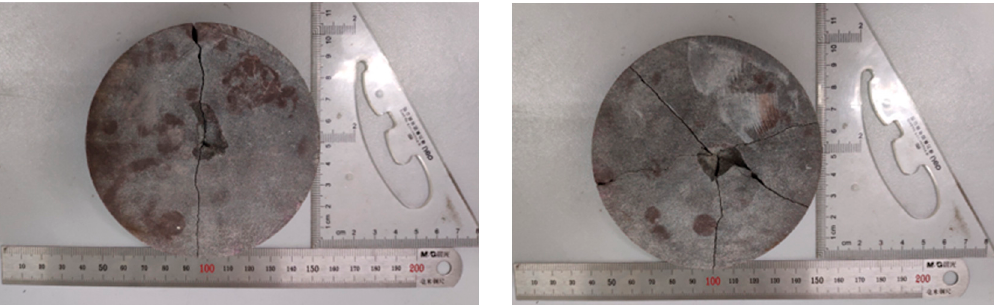
Figure 24. Morphology of rock after electrical breakdown.